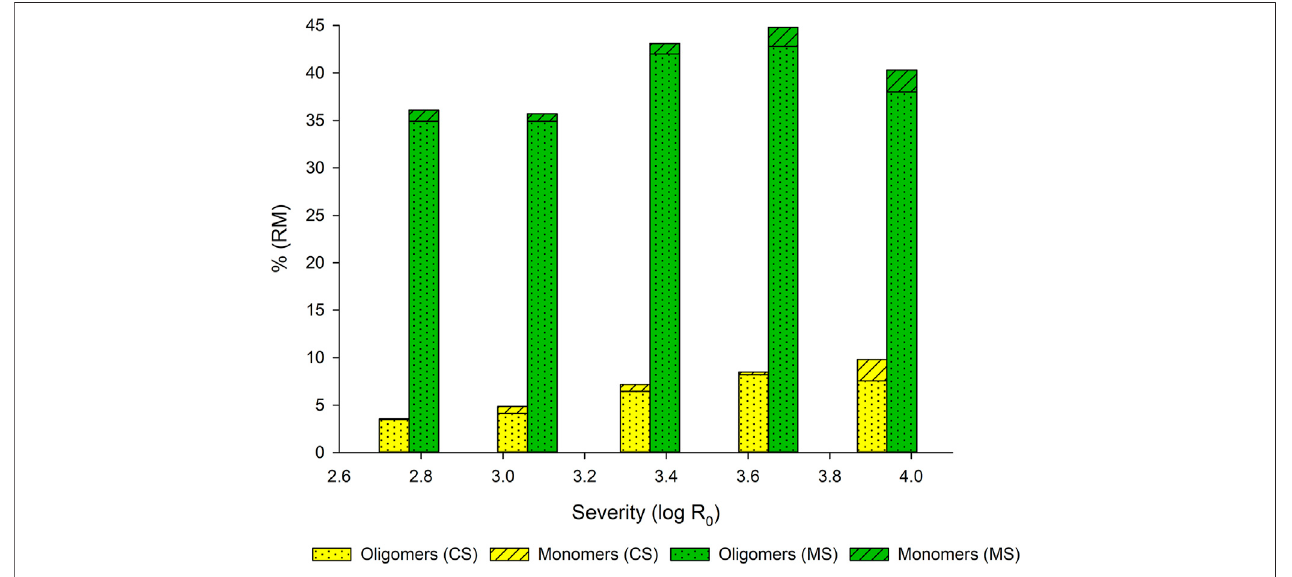
FIGURE 2 | Effect of steaming severity on monomer and oligomer/polymer ratio in fi ltrates obtained from CS and MS.